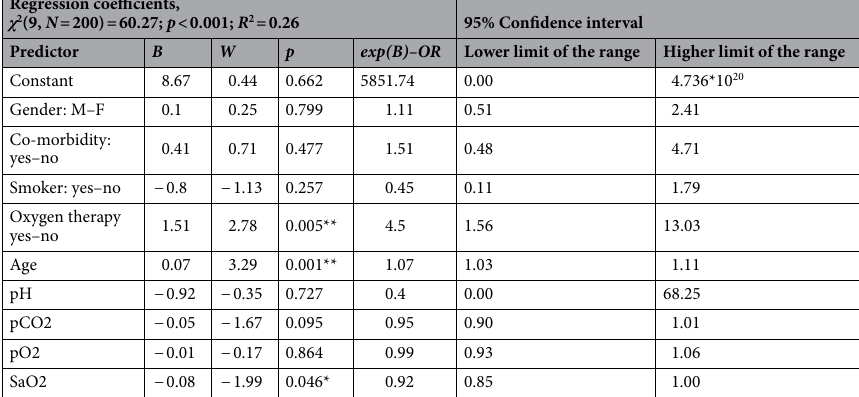
Table 5. Predictors of death in patients diagnosed with COVID-19. R 2 —coefficient for model fit; χ 2 —test statistic; df —degrees of freedom; B —estimating factor; W —test statistic; p —statistical significance; exp(B) — OR— odds ratio; * p < 0.05; ** p < 0.01; *** p <